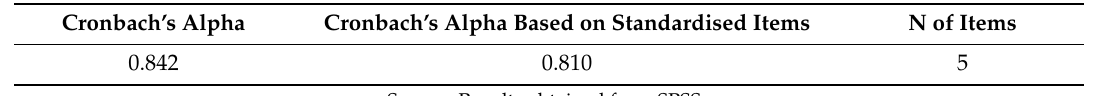
Table 3. Reliability Statistics.